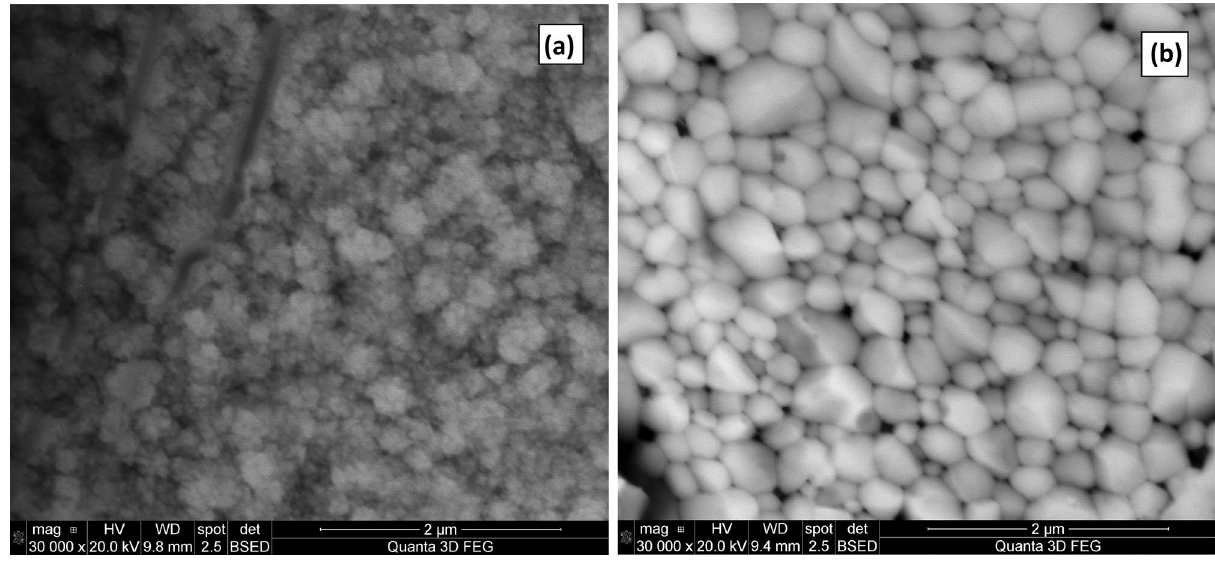
Figure 11. SEM micrographs of (a) AD-CdMnTe layers and (b) CCT-CdMnTe layers grown at 1430 mV cathodic